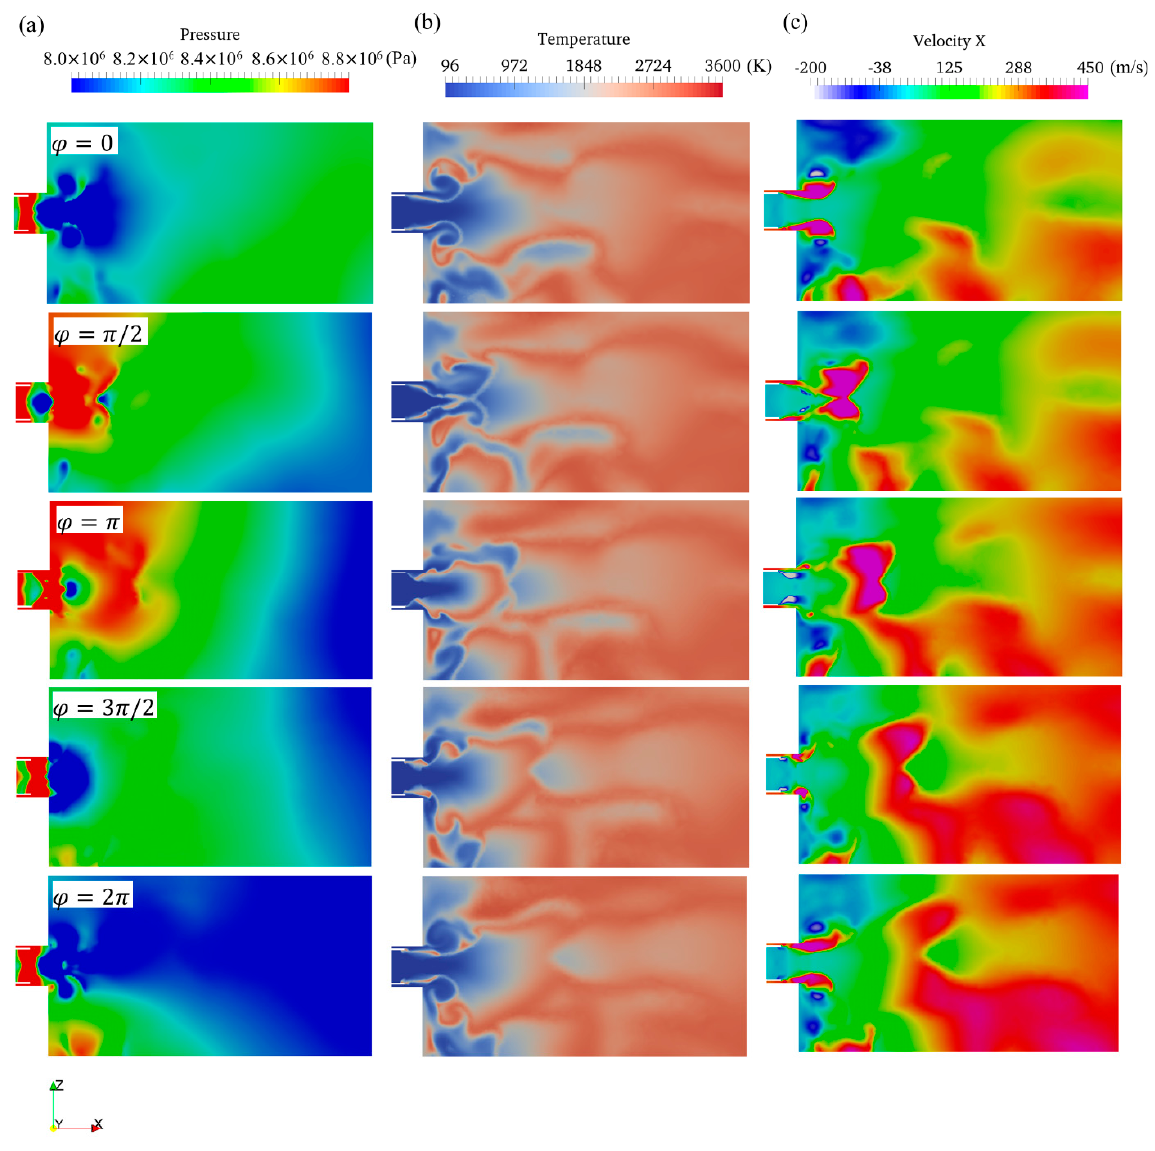
Figure 13. Contour plots of the ( a ) pressure, ( b ) temperature, ( c ) x -velocity according to the phase changes for the analysis plane of injector B in one period of the cycles. The variation in the RI in the analysis plane of injector B in one period is shown in Figure 18. In the pressure drop phases, a negative RI (max. − 2 × 10 7 W/m 3 ) is maintained for a short time; however, in the pressure rise phases, a positive RI (max. 8 × 10 7 W/m 3 ) is maintained for a long time. In the analysis plane of injector B, the time-averaged RI for one period is calculated as +243,156 W/m 3